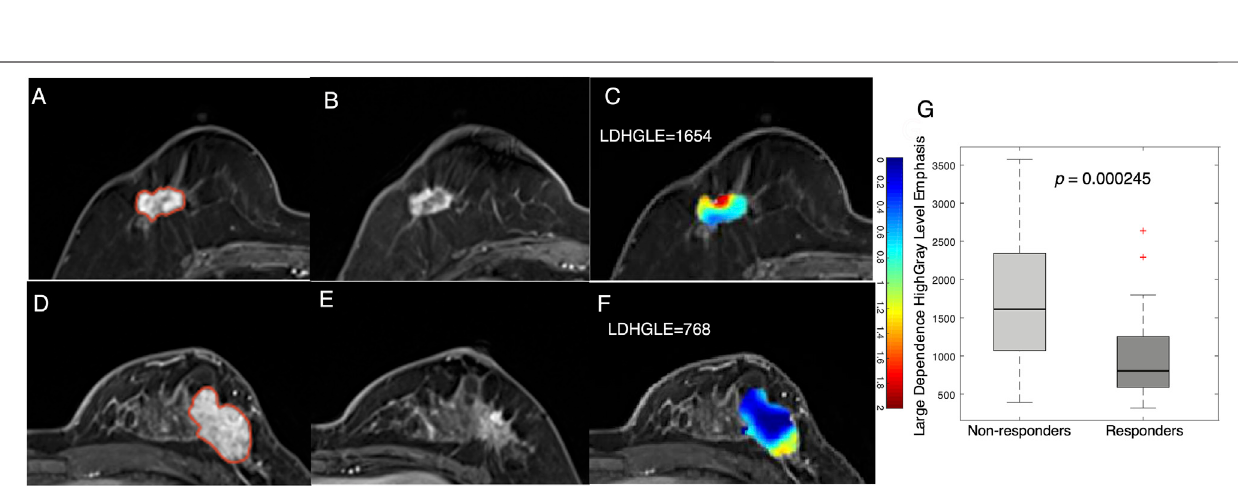
FIGURE 4 | Examples feature of large dependence high gray-level emphasis (LDHGLE) in nonresponders and responders. Images from a nonresponder breast cancerpatient(aged 59 years old) (A) pre- and (B) post-treatment and (C) aJacobian map ofthe tumor ROI (LDHGLE (cid:1) 1654). Images from aresponder breast cancer patient[aged43 yearsold) (D) ]pre-and (E) post-treatment and (F) aJacobianmapofthetumor ROI(LDHGLE (cid:1) 768). (G) Boxplotrepresentingthefeaturedistributions in nonresponders and